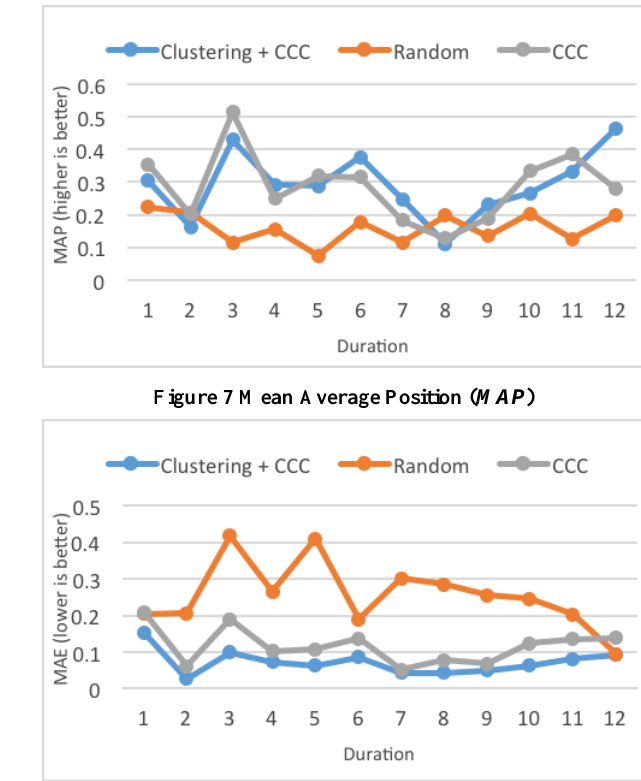
Figure 8 Mean Average Error ( MAE